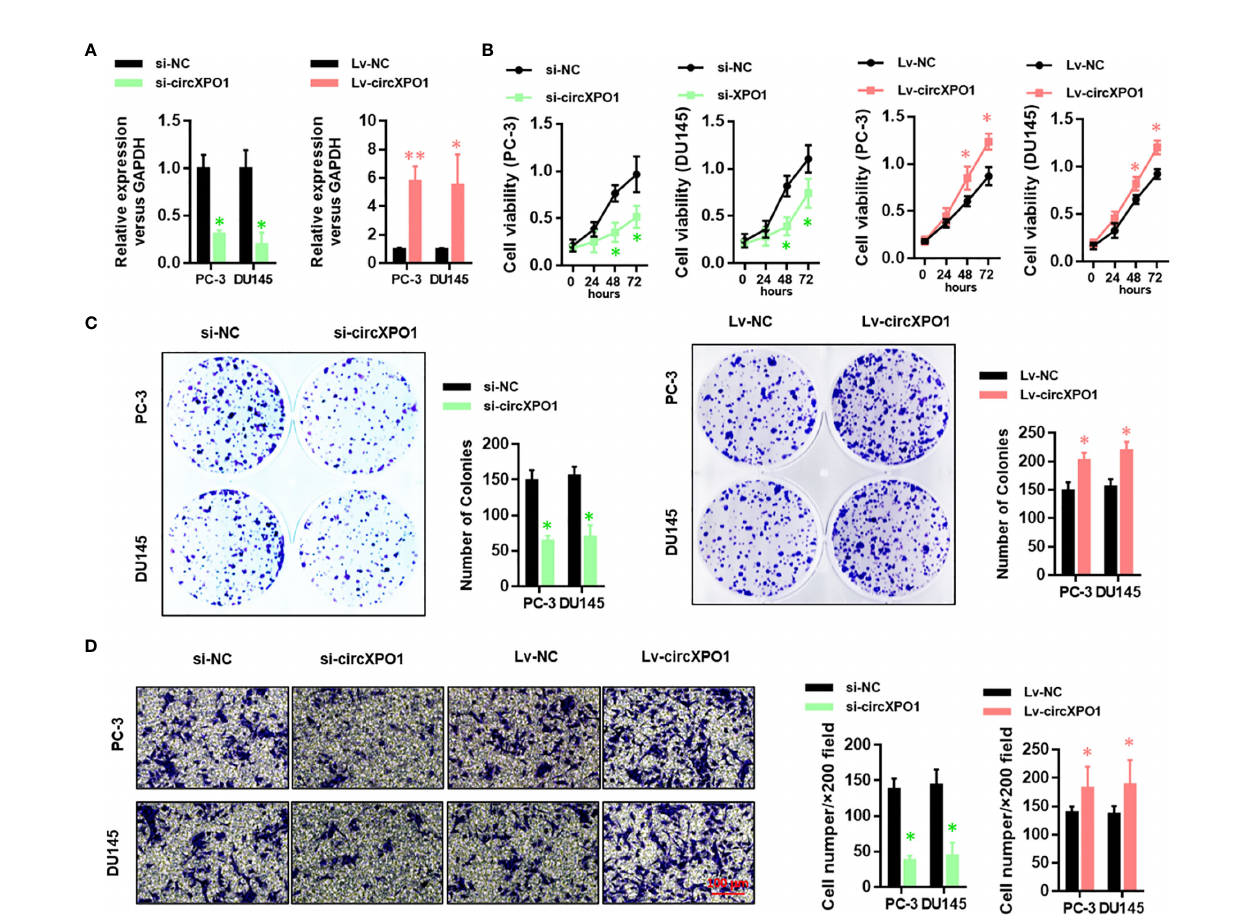
FIGURE 2 | CircXPO-1 promoted cell proliferation, colony formation, and invasion in prostate cancer cells. (A) PC-3 and DU145 cells were transfected with small interfering RNA against circXPO1 (si-circXPO1), negative control (si-NC), lentiviral vectors expressing circXPO1 (Lv-circXPO1), or Lv-NC. qRT-PCR was performed to evaluate the knockdown and overexpression ef fi ciency. (B) PC-3 cells were transfected as indicated. CCK-8 assay was conducted to measure cell viability at 0, 24, 48, and 72 h after transfection. (C) PC-3 and DU145 cells were transfected as indicated and incubated for 7 days. A colony formation assay was performed. (D) PC-3 and DU145 cells were transfected as indicated. Transwell assay was performed to evaluate the invasive ability of cells. Data are expressed as the means ± SD. * P < 0.05, ** P < 0.01, vs. NC; n =